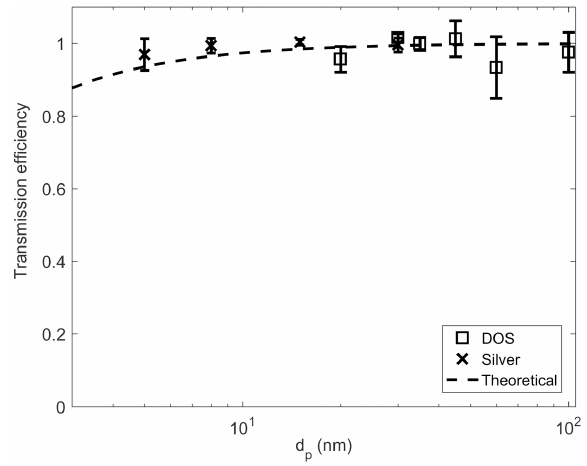
Figure 4. The particle transmission efficiency in the TSAR oxida- tion reactor. The dashed line shows the theoretical transmission ef- ficiency when the diffusion losses are taken into account. Error bars show the standard deviation.